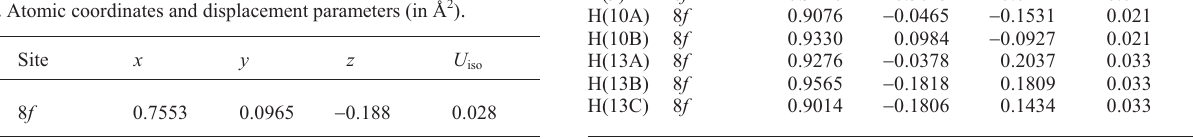
Table 2. Atomic coordinates and displacement parameters (in Å 2 ) .